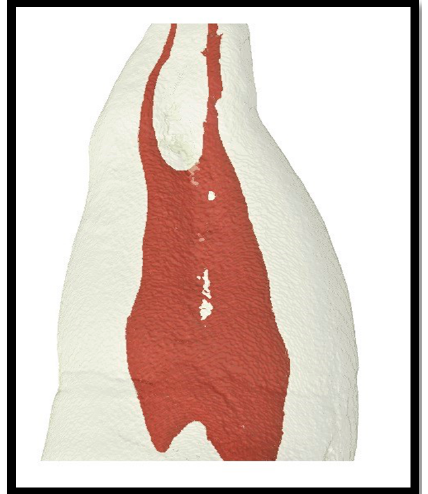
Figure 15. Micro-CT image showing the coronal third location of the isthmus.